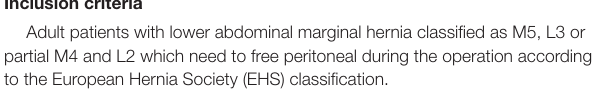
TABLE 1 | Inclusion and exclusion criteria. Inclusion criteria